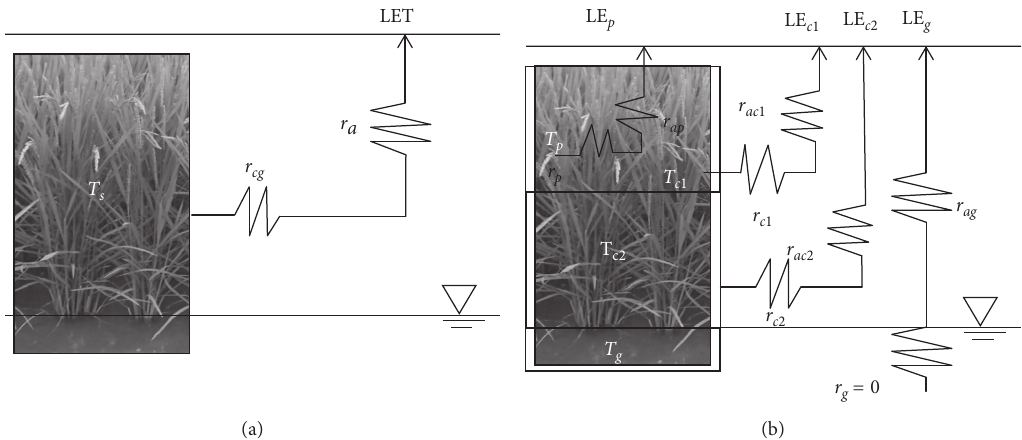
Figure 1: A schematic representation of the aerodynamic resistance and upper and lower canopy resistances of (a) one-layer and (b) three- layer models. LET was the latent heat flux for the whole canopy (W m − 2 ), T s was the surface temperature of the paddy field ( ° C), r a was the aerodynamic resistance to the transfer of sensible heat between the whole rice canopy and water surface (s m − 1 ), r cg was the total canopy resistance consists of rice canopy resistance and water surface resistance (s m − 1 ), LE p was the latent heat flux on a panicle (W m − 2 ), LE c 1 was the latent heat flux between upper layer rice canopy and atmosphere (W m − 2 ), LE c 2 was the latent heat flux between lower layer rice canopy and atmosphere (W m − 2 ), LE g was the latent heat flux between water surface beneath the rice canopy and atmosphere (W m − 2 ), T p was the panicle temperature ( ° C), T c 1 was the upper layer canopy temperature ( ° C), T c 2 was the lower layer canopy temperature ( ° C), T g was the water temperature ( ° C), r ap was the aerodynamic resistance to the transfer of sensible heat between panicle and atmosphere (s m − 1 ), r ac 1 was the aerodynamic resistance to the transfer of sensible heat between upper layer rice canopy and atmosphere (s m − 1 ), r ac 2 was the aerodynamic resistance to the transfer of sensible heat between lower layer rice canopy and atmosphere (s m − 1 ), r ag was the aerodynamic resistance to the transfer of sensible heat between water surface and atmosphere (s m − 1 ), r p was the panicle transpiration resistance (s m − 1 ), r c 1 was the upper layer canopy resistance (s m − 1 ), r c 2 was the lower layer canopy resistance (s m − 1 ), and r g was albedo of water surface (s m − 1